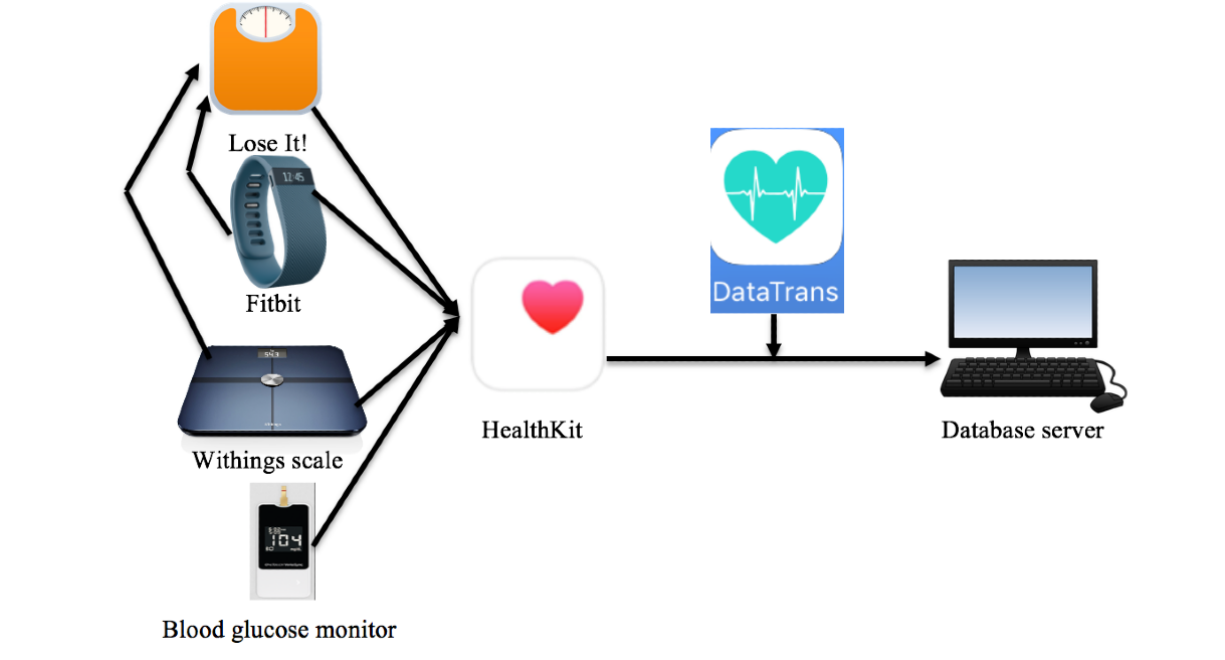
Figure 1. The infrastructure supporting remotely transmitted data